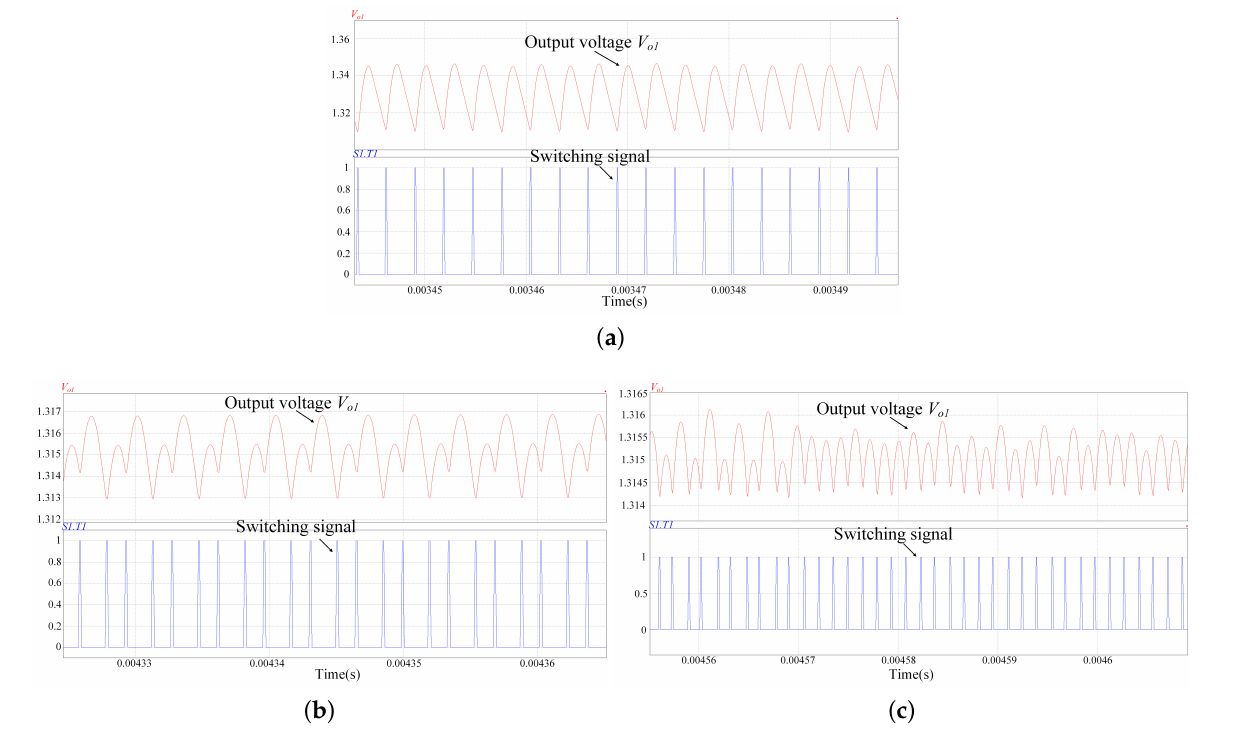
Figure 8. Simulation waveforms of the system with varying: ( a ) P CPL = 6 W. ( b ) P CPL = 24 W. ( c ) P CPL = 33.1 W.